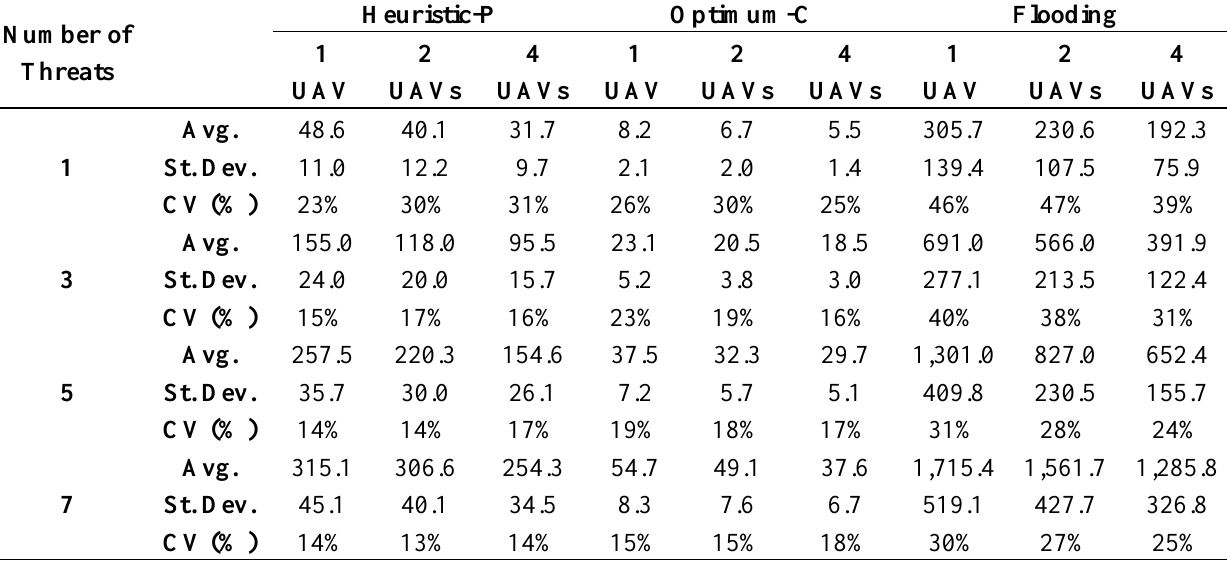
Table 2. Average, standard deviation and coefficient of variance for the number of messages sent using Heuristic-P, Optimum-C and Flooding in the first simulation